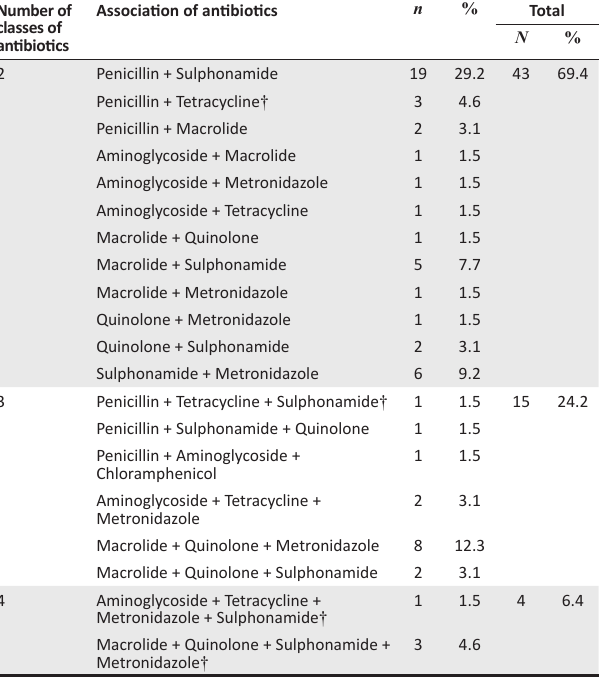
TABLE 3: Association of classes of antibiotics. Number of classes of antibiotics